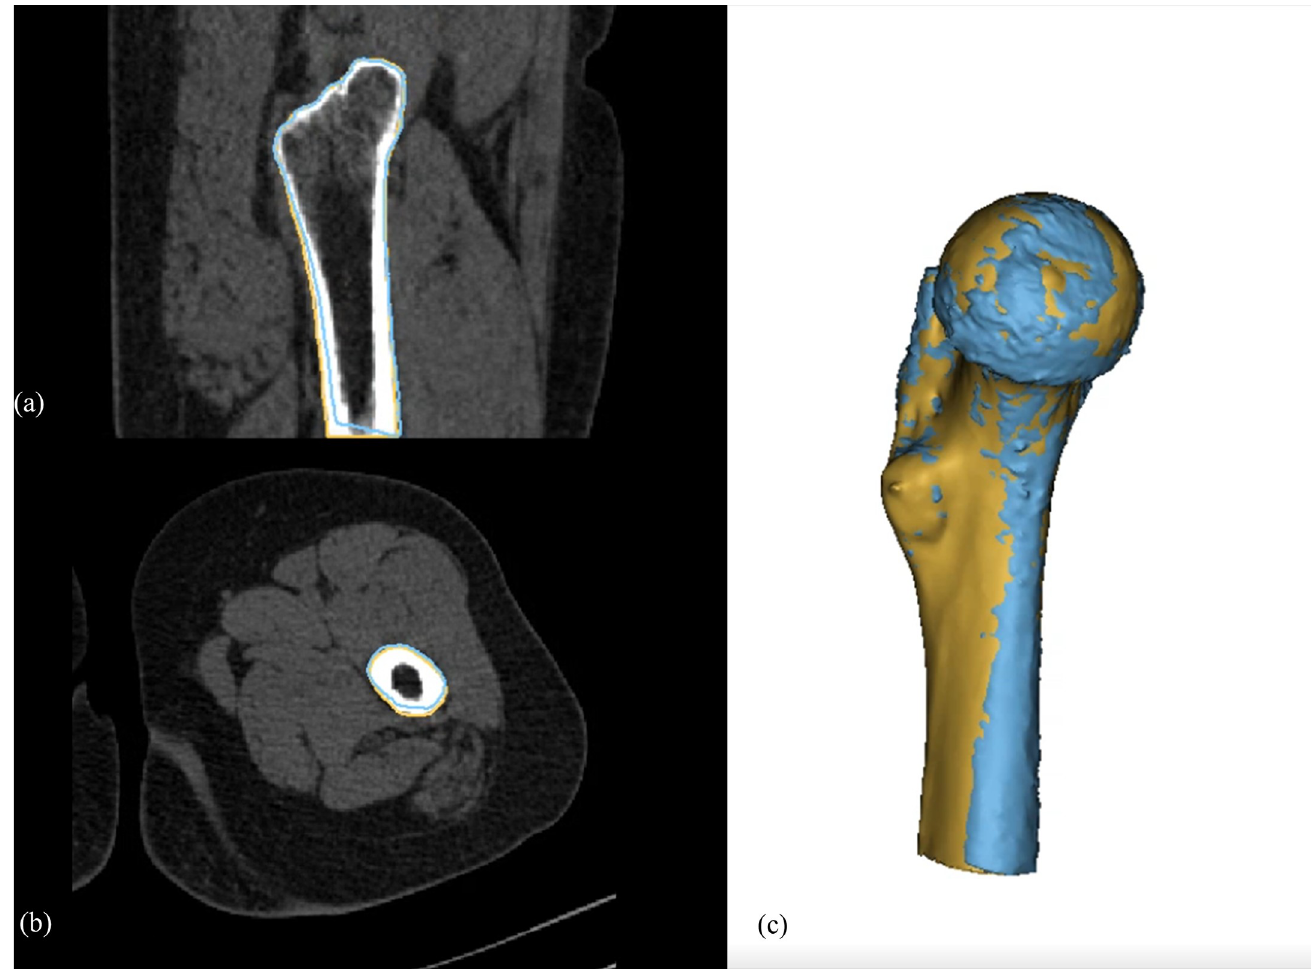
Fig 5. Distortion of MR model at the periphery of the magnetic field. Sagittal (a), axial (b), and 3D-modelling images (c) of a proximal femur in a 32-year-old male patient. The blue line indicates the bone contour achieved from the Dixon-VIBE-3D-MRI model, and the brown line indicates that of the CT model. The anterior distortion of the MRI model in respect to the CT model is aggravated at the periphery of the magnetic field (femur shaft area).